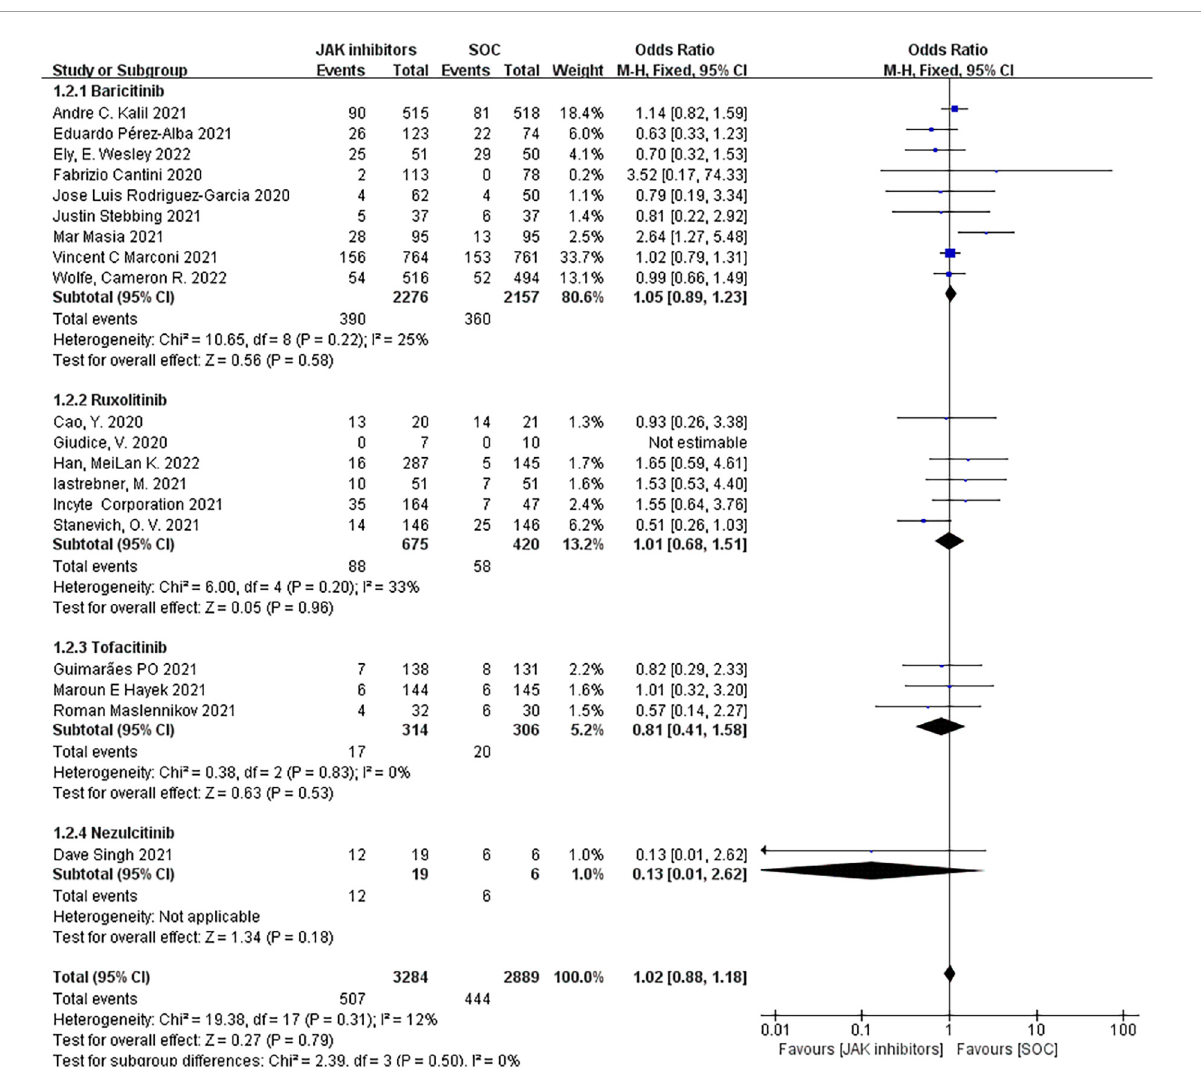
FIGURE4 Forest plots of effect of JAK inhibitors compared to SOC on adverse events. The study was divided into four subgroups by different drugs. SOC, standard of care.